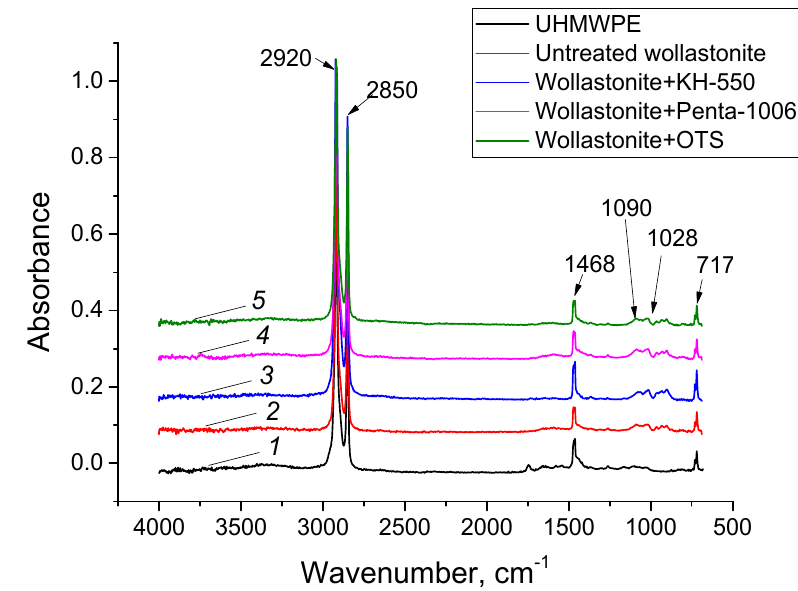
Figure 5. FT-IR spectra of neat UHMWPE and the UHMWPE-based composites.